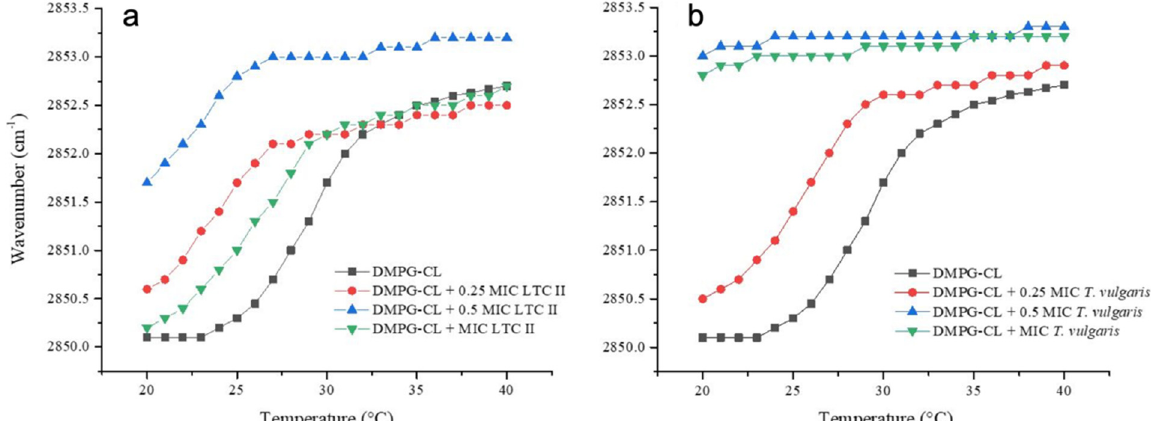
Figure 7. Peak positions of the symmetric stretching vibration bands of the methylene groups as a function of temperature. S. aureus representative model membrane (DMPG/CL, 80:20) in the presence of different concentrations of ( a ) LTC II and ( b ) TV EOs.